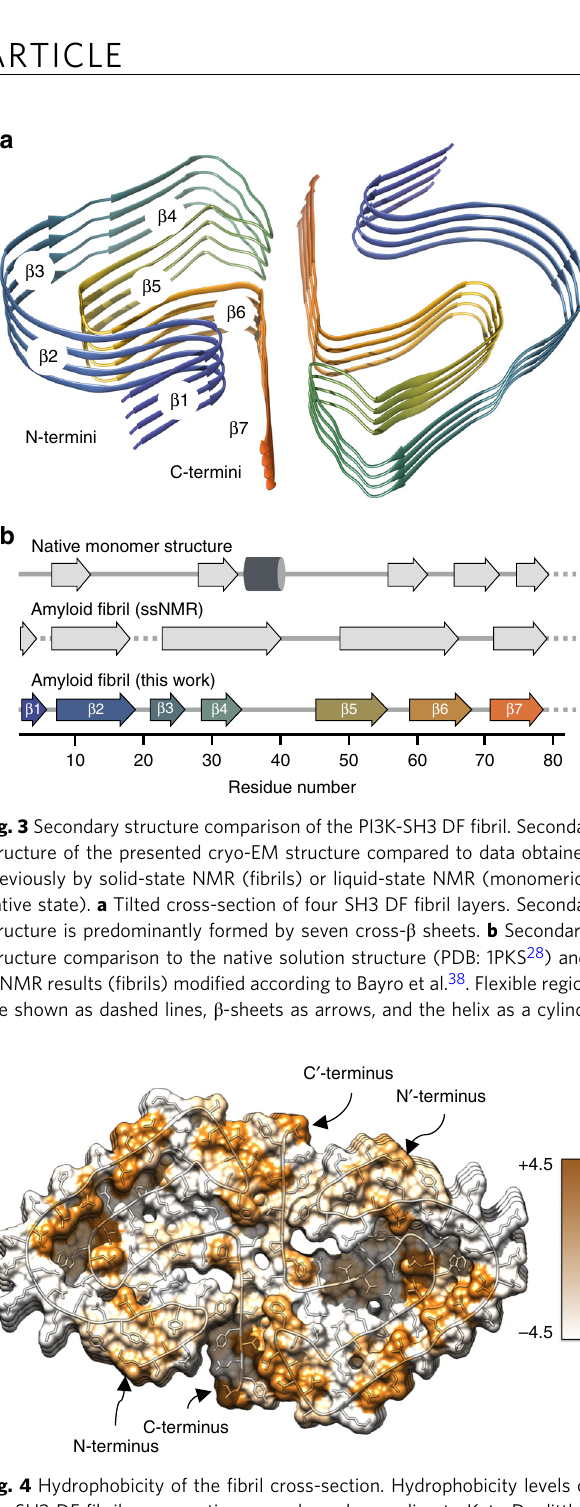
Fig. 4 Hydrophobicity of the fi bril cross-section. Hydrophobicity levels of the SH3 DF fi bril cross-section are coloured according to Kyte-Doolittle 61 . Hydrophobic residues are mainly packed within the fi bril core, while hydrophilic residues point towards the solvent. Hydrophobic patches in both monomers are clearly visible and are spanning several β -sheets the fi bril axis (Fig. 5). The subunits within a proto fi lament therefore interact not only with the layer directly above ( i + 2) and below ( i − 2), but also with layers up to ( i + 6) and ( i − 6); the subunits are interlocked.